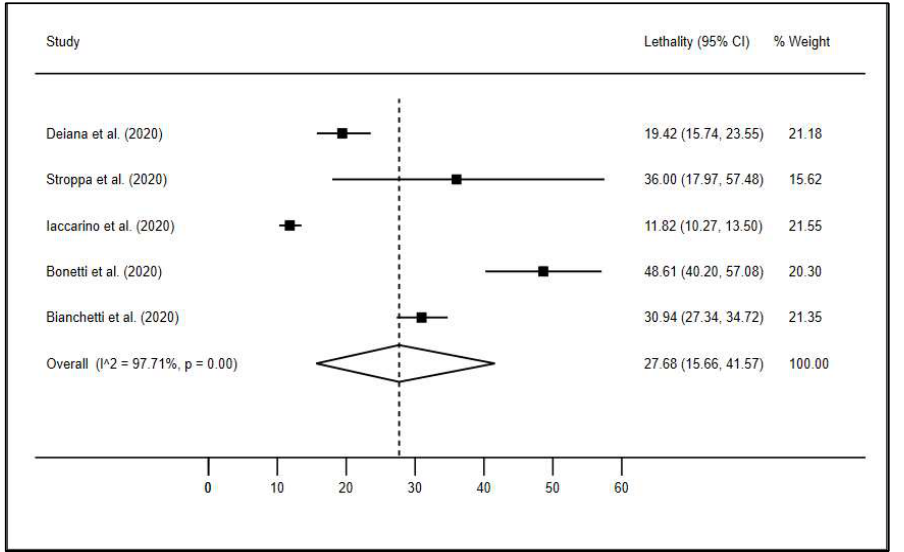
Figure 2. Mortality rate in the elderly obtained in the meta-analysis.